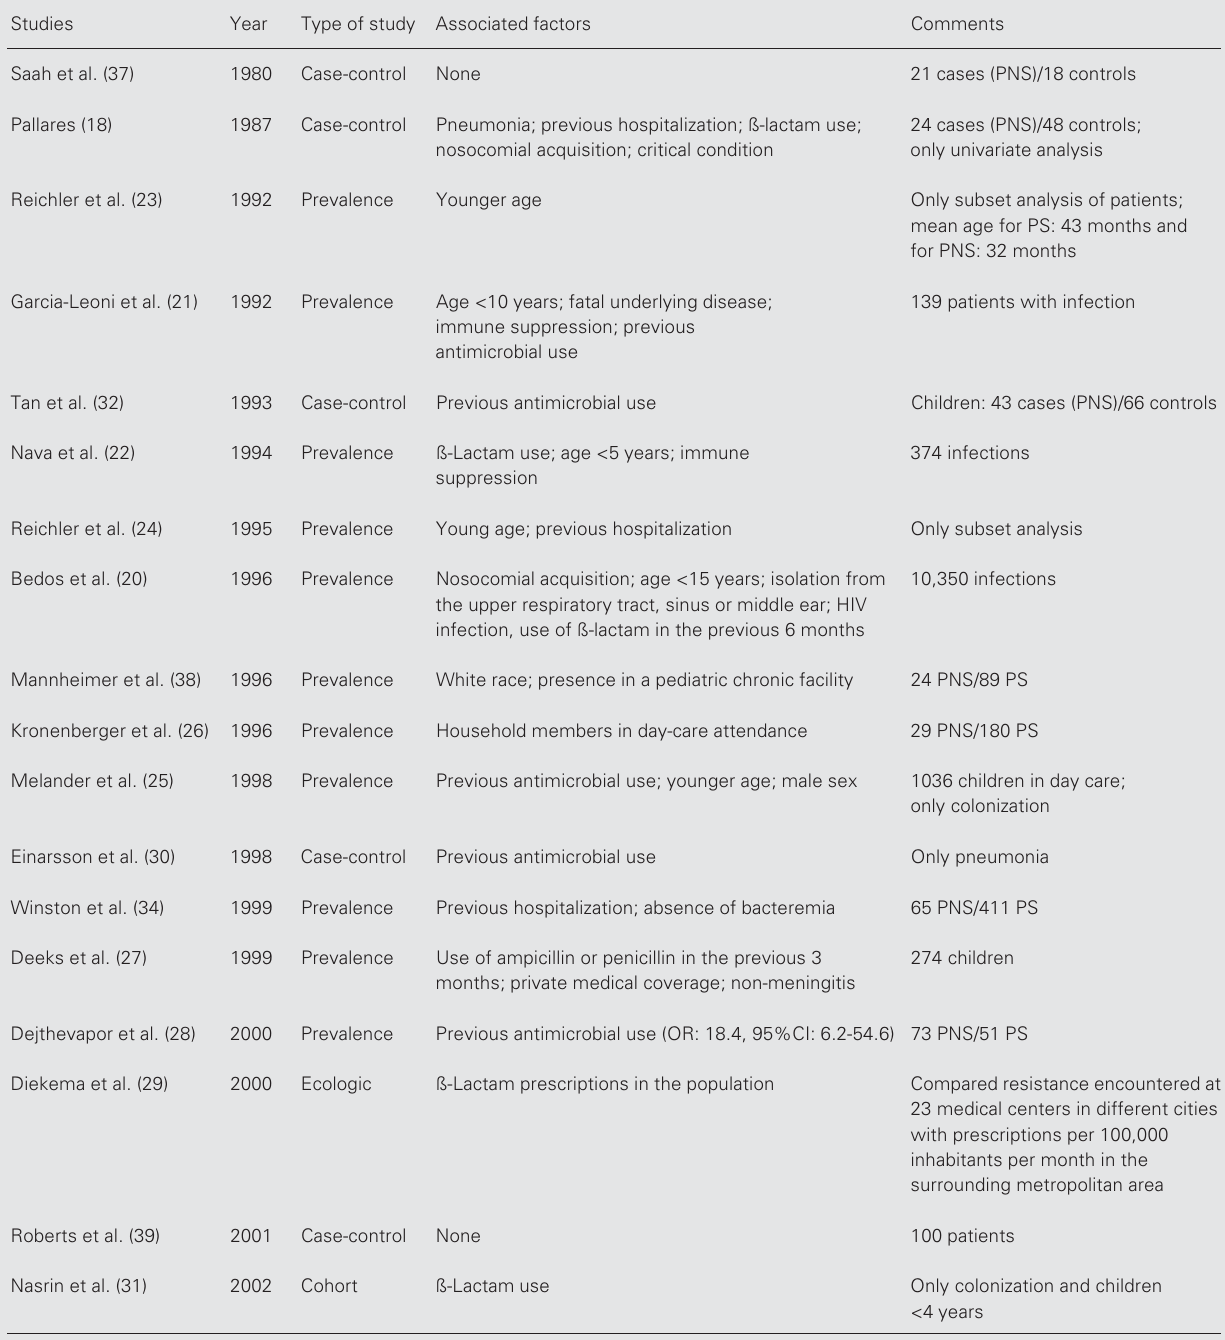
Table 3. Studies of factors associated with penicillin-nonsusceptible Streptococcus pneumoniae infection or